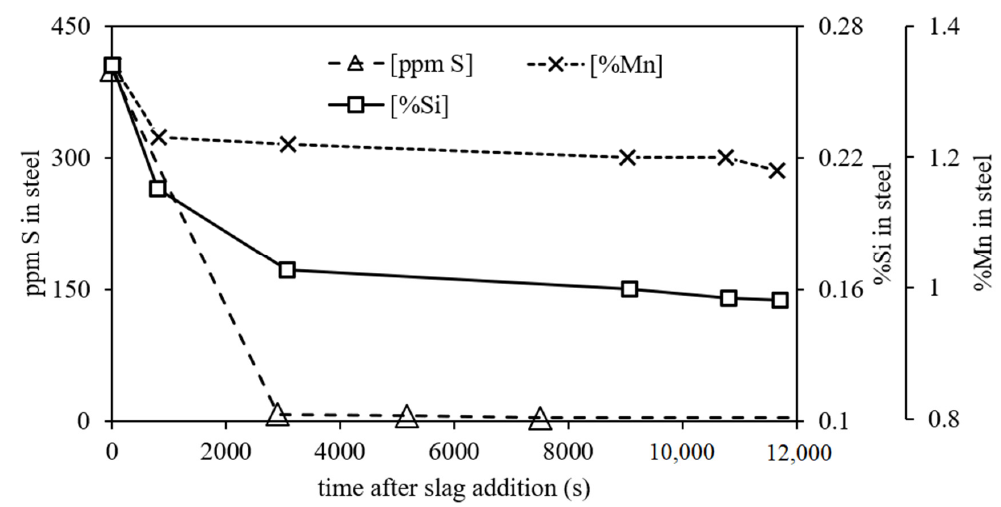
Figure 2. Evolution of chemical composition of steel in contact with basic slag over time after slag addition. Triangular markers represent the evolution of [S], × markers represent [Mn], and squares [Si].